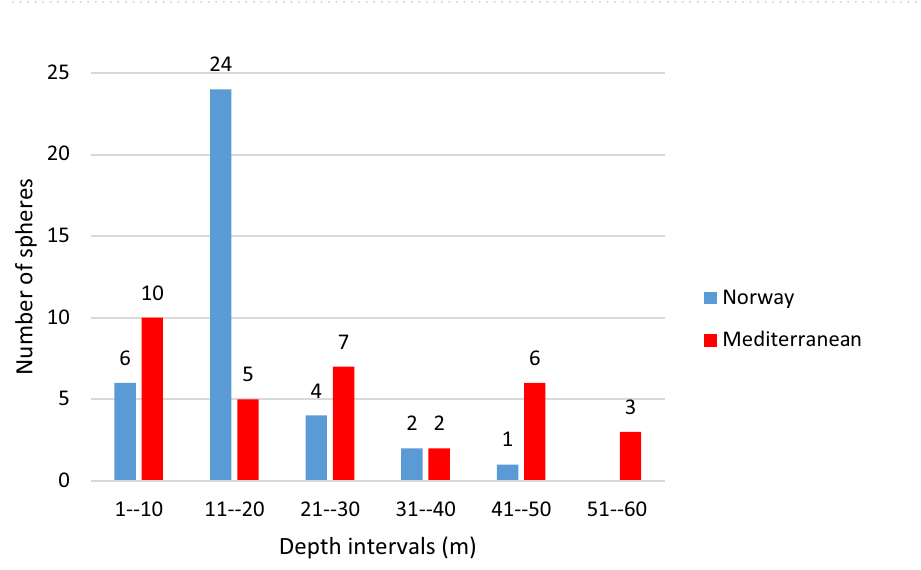
Figure 7. Sphere observations at different depth intervals, from NE Atlantic Ocean, including the Mediterranean